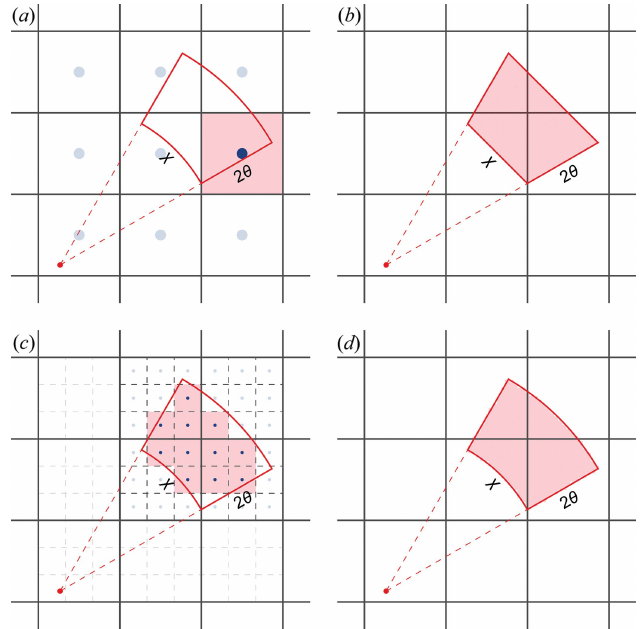
Figure 1 Pixel splitting improves assignment of areas of the detector into the appropriate (2 (cid:2) , (cid:3) ) bin during integration. ( a ) No splitting. Here only the pixels with their center within a (2 (cid:2) , (cid:3) ) bin are assigned entirely to said bin. ( b ) Method employed by PyFAI . Here the analytical area of the trapeze spanned by the azimuthal lines fall into the bin, yet it does not take into account the curvature of the arc. Pixel splitting by super- sampling ( c ) 3 or ( d ) 20 times in both cardinal directions. This is the method employed by MatFRAIA . The red area shows which part of the detector will be included in the resulting (2 (cid:2) , (cid:3) )